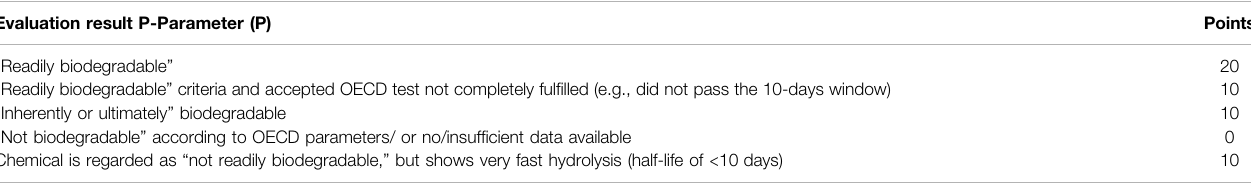
TABLE 1 | Points in the P-Parameter evaluation.